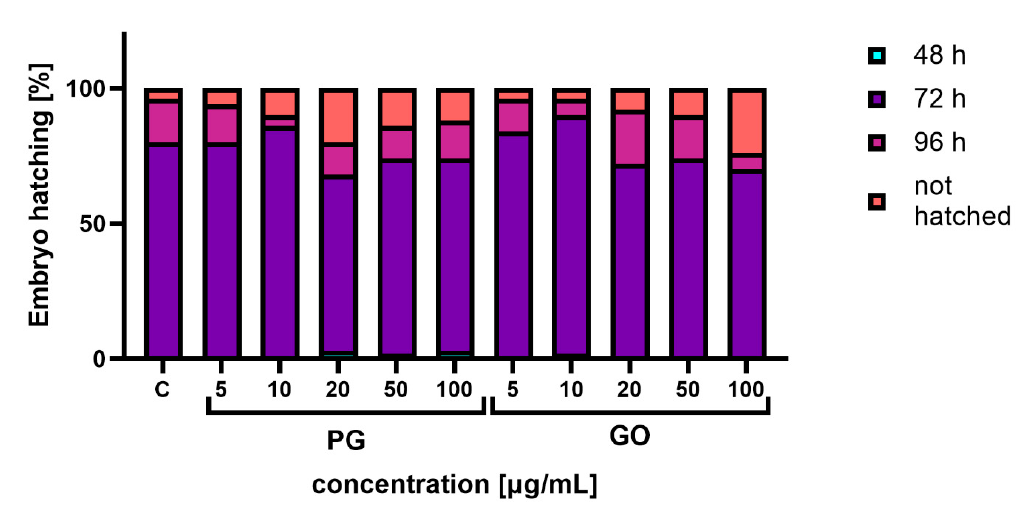
Figure 2. Percentage of larvae hatched after 48 hpf (hours after fertilization), 72 hpf and 96 hpf and percentage of non- hatched larvae on the last day of the experiment. Abbreviations: C—control group (untreated cells); PG—pristine graphene; GO—graphene oxide.